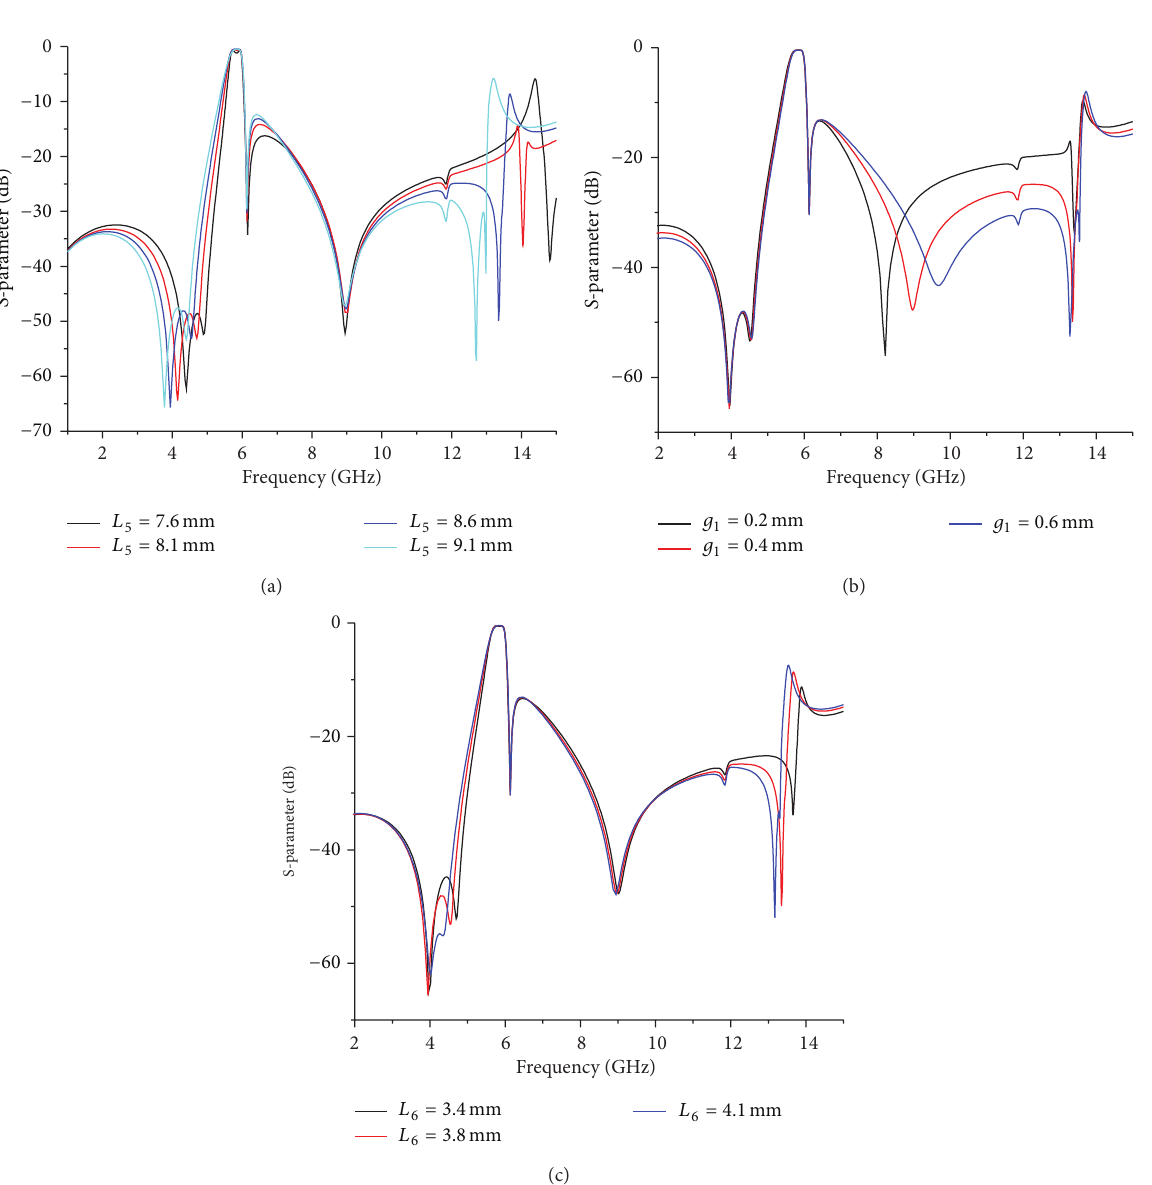
Figure 5: Simulated responses of the proposed BPF for different values of (a) 𝐿 5 , (b) 𝑔 1 , and (c) 𝐿 6